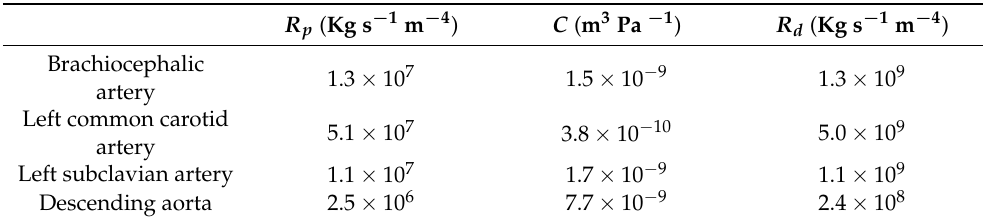
Table 2. RCR values of the Windkessel models for the boundary conditions assigned to the aorta outlets: the three supra-aortic vessels, i.e., the brachiocephalic artery, the left common carotid artery, and the left subclavian artery, and the descending aorta.